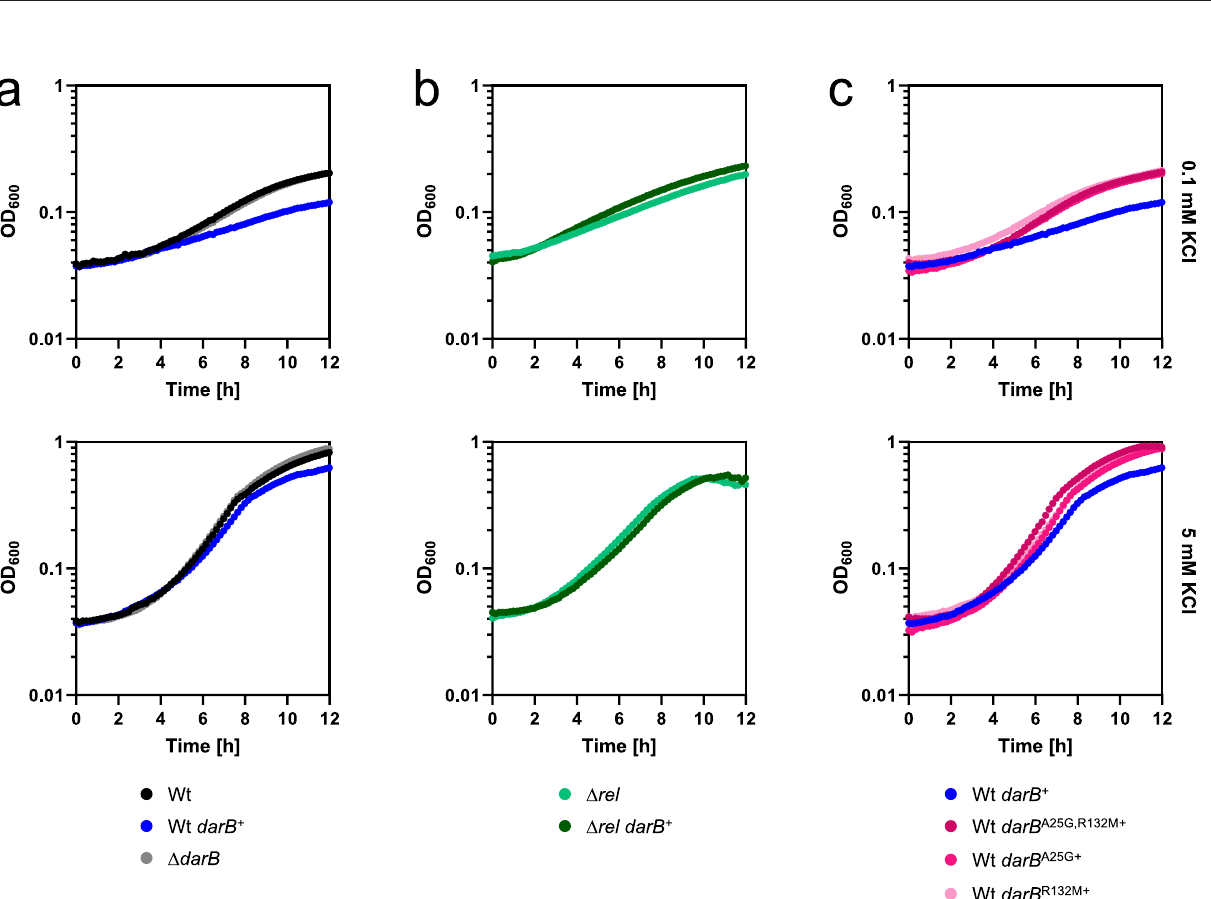
Fig. 3 Overexpression of DarB is toxic. Growth experiments of a wild type B. subtilis (black), GP3407 ( Δ darB; gray), wild type + pGP3306 ( darB + , blue). b GP3419 ( Δ rel , bright green) and GP3419 ( Δ rel, darB + , dark green), and c wild type + pGP3437/3441/3601 ( darB A25G , darB R132M , darB A25G,R132M , pink) in MSSM minimal medium with 0.1 mM KCl (upper panel) or 5 mM KCl (lower panel). Growth was monitored in an Epoch 2 Microplate Spectrophotometer (BioTek Instruments) at 37 °C with linear shaking at 237 cpm (4 mm) for 12 h. The growth experiment was conducted three times and a representative curve is shown. Source data are provided as a Source data fi